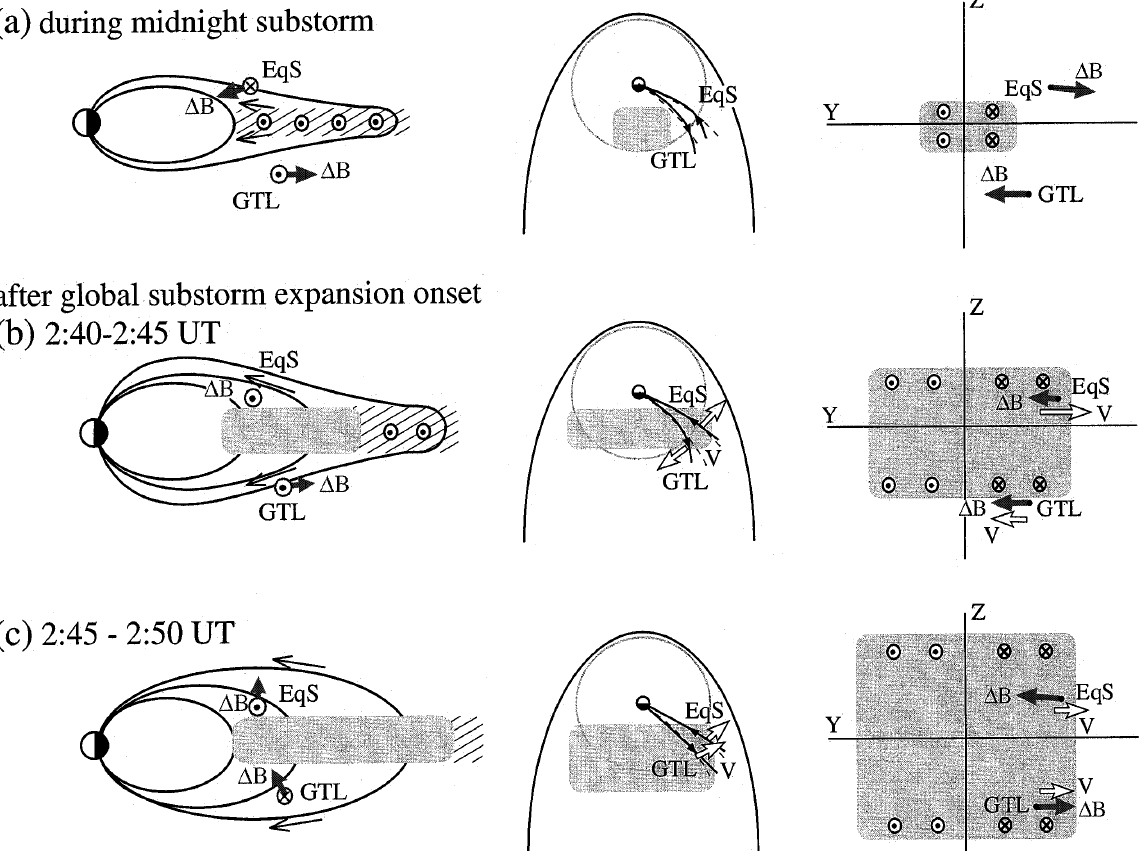
circles . The left three panels show the expected change in the field configuration projected in the X-Z plane. The middle three panels show the relationship between the field line bending and the flow disturbance in the equatorial plane. Here the projected field lines observed are indicated with the solid lines with an arrow (indicating the direction of the field). The dotted lines are the projected model field lines. The right three panels show the relationship between the flow and field disturbances in